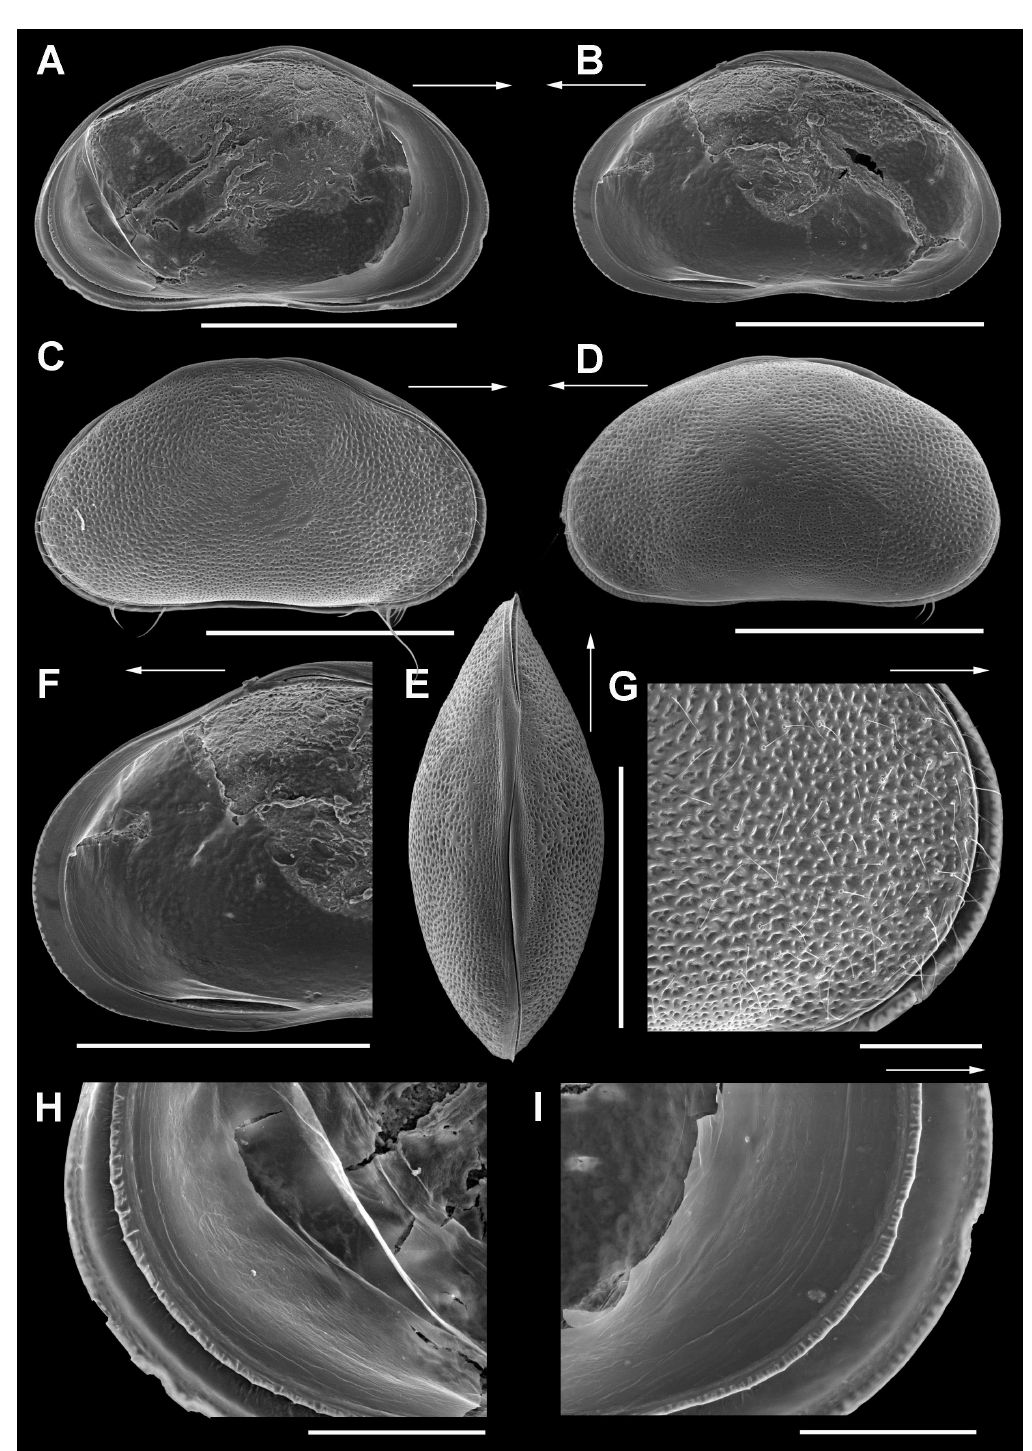
Fig. 7. Cyprinotus drubea sp. nov., ♀♀ A-1 juveniles. A . LVi (INV.156002/OC.3402). B . RVi (RBINS- INV.156002/OC.3402. C . CpRL (MNHN-UI-2019-781). D . CpLL (MNHN-UI-2019-779). E . CpD (MNHN-UI-2019-780). F . RVi, detail of anterior part (RBINS-INV.156002/OC.3402). G . CpRL, detail anterior (MNHN-UI-2019-781). H . LVi, detail of posterior part (RBINS-INV.156002/OC.3402). I . LVi, detail of anterior part (RBINS-INV.156002/OC.3402). Arrows indicate anterior side. Scale bars: A–E = 500 µm, F = 400 µm, G–I= 100